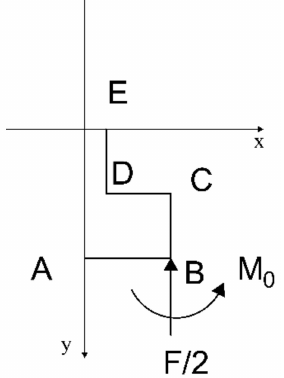
Figure 3. The internal forces of a 1/4